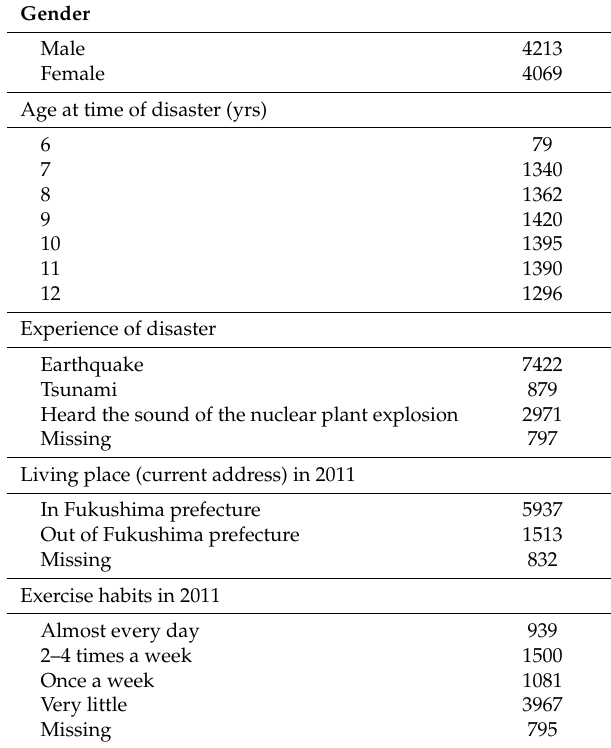
Table 1. Sociodemographic characteristics of the study sample ( n =